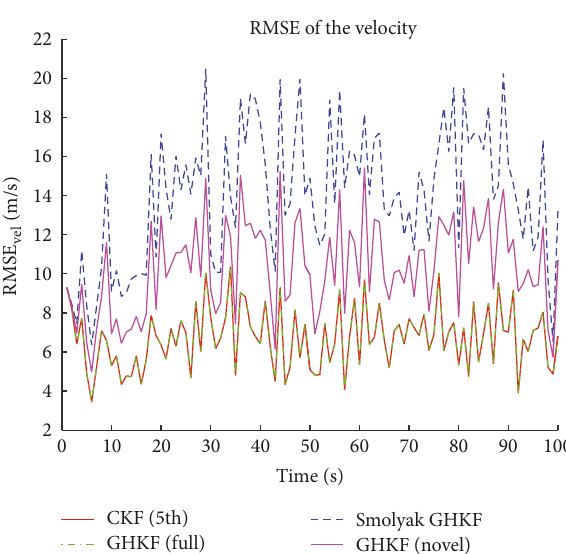
Figure 5: RMSEs of position of different filters.